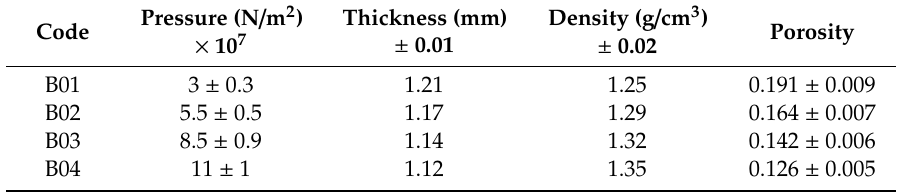
Table 1. Pellet thickness and density, applied pressure, and calculated porosity according to Equation (2).